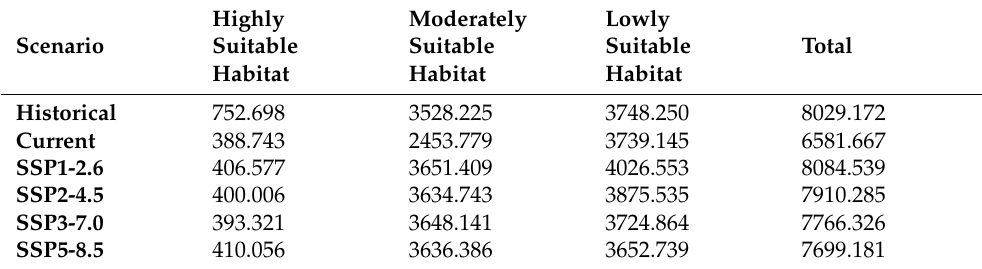
Figure 4. Habitat suitability distribution of P. flavescens according to occurrence records. Table 2. Change of suitable habitat ( × 10 4 km 2 ) of P. flavescens in historical, current, and four levels of future scenarios.